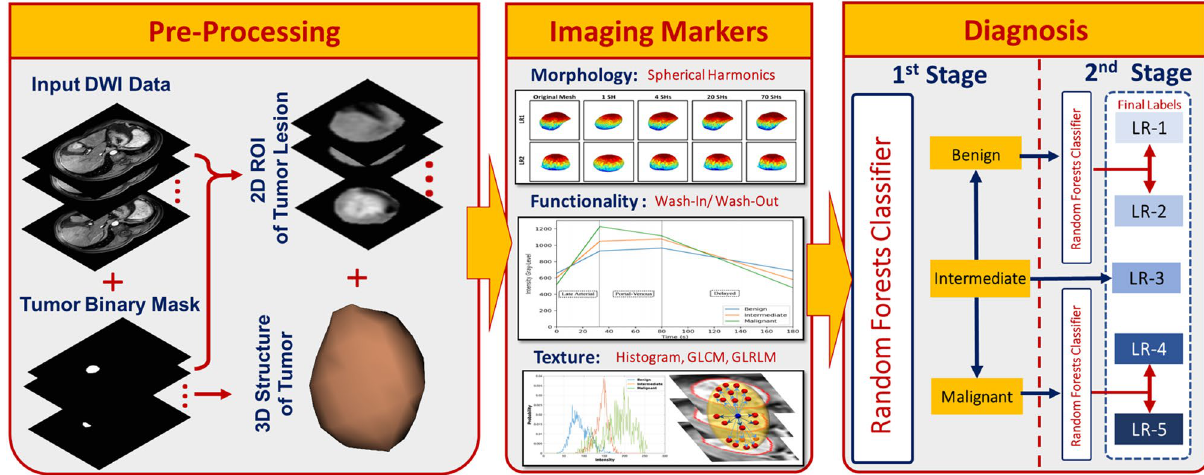
Figure 1. The proposed computer-aided diagnosis (CAD) system for detecting and grading liver cancer tumors. CE-MRI Acquisition